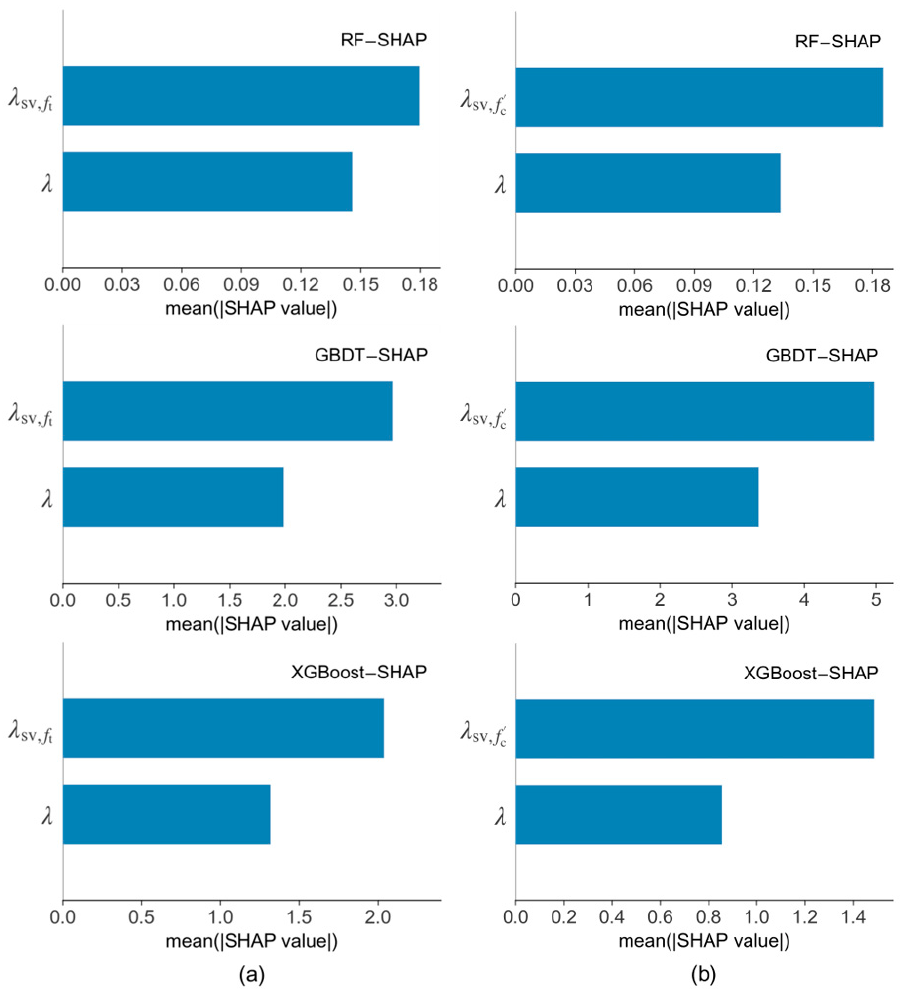
Figure 7. SHAP feature importance analysis (Note: The horizontal axis mean (|SHAP value|) indicates features’ average impact on model output magnitude). ( a ) model 1 ( λ , λ sv, f (cid:48) c